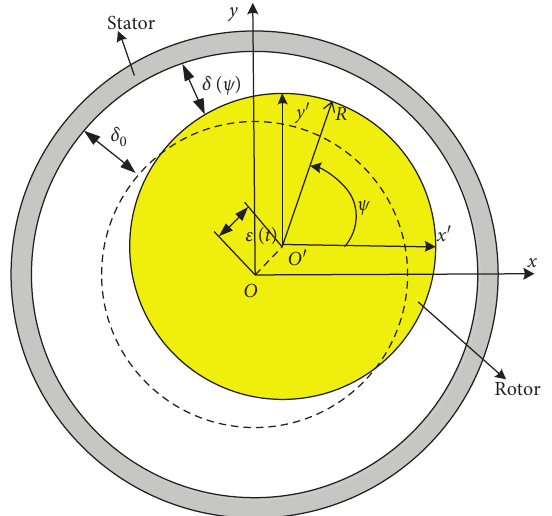
Figure 1: The schematic diagram of rotor eccentricity under demagnetization.